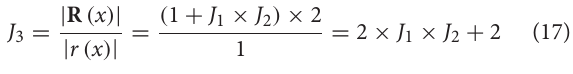
Algorithm 1 | Pseudocode of 18-way data